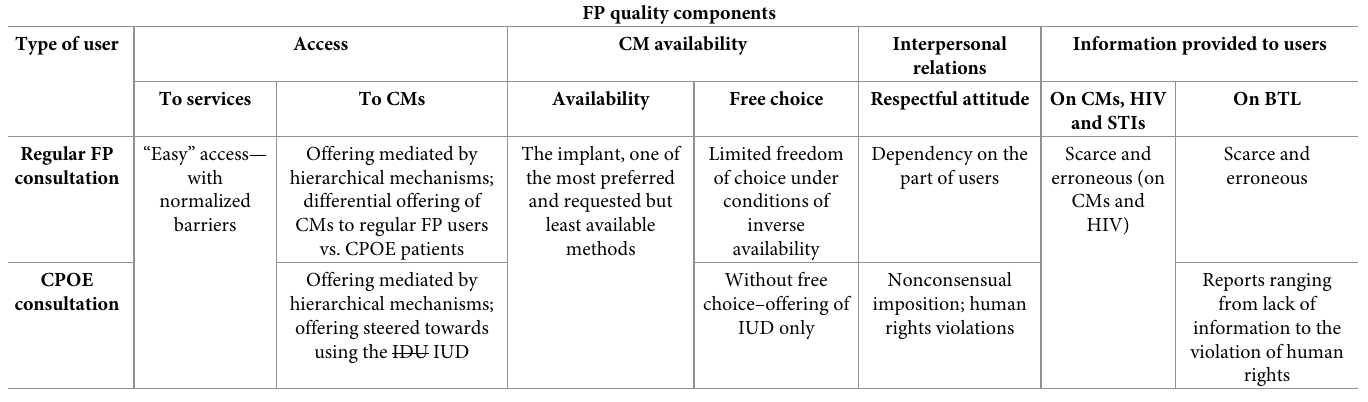
Table 2. FP quality components. Summary of user perceptions by type of